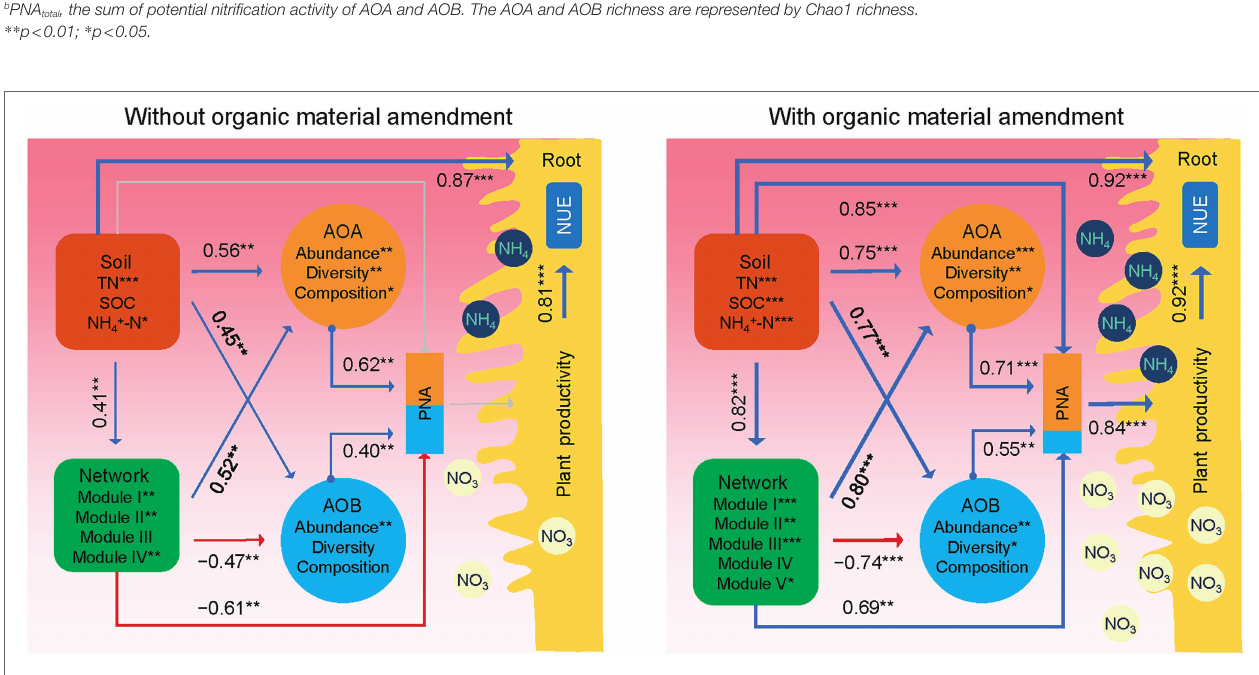
FIGURE 6 | Schematic figure displaying the effects of soil properties, AOA and AOB populations on PNA total , plant productivity, and nitrogen use efficiency (NUE) based on structural equation modeling analysis of treatments without and with organic material amendments. The latent variables (soil properties, AOA and AOB, and network) inside the boxes were used to integrate the effects of multiple conceptually related variables into a single-composite effect. Soil properties include soil organic carbon (SOC), total nitrogen (TN), and ammonia nitrogen (NH 4+ -N). The AOA and AOB are represented by the amoA gene abundance, diversity (Chao1 richness), and composition (PCoA1). The co-occurrence networks are represented by module eigengenes. PNA is the sum of AOA and AOB potential nitrification activity, and the contributions of AOA and AOB to PNA were colored in orange and blue, respectively. Plant productivity is the sum of grain yield and straw biomass. Blue and red lines indicate positive and negative effects, respectively. The width of arrows indicates the strength of significant standardized path coefficients. Paths with non-significant coefficients are displayed as gray lines. *** p < 0.001; ** p < 0.01; * p <